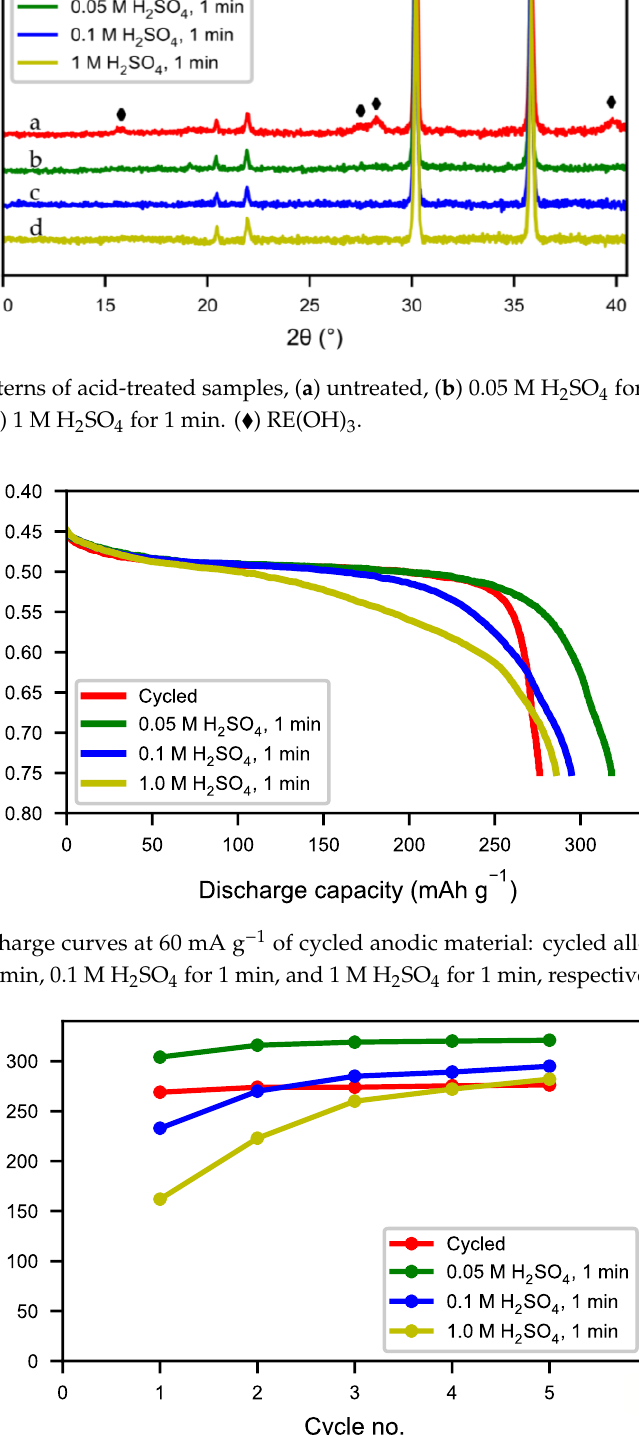
Figure 14. Discharge capacity measured for the first 5 cycles for the treated and untreated samples. For all 5 cycles, a discharge rate of 60 mA g −1 (0.2 C) was used. The measured capacity was adjusted to take the added Ni in the electrode fabrication into account.